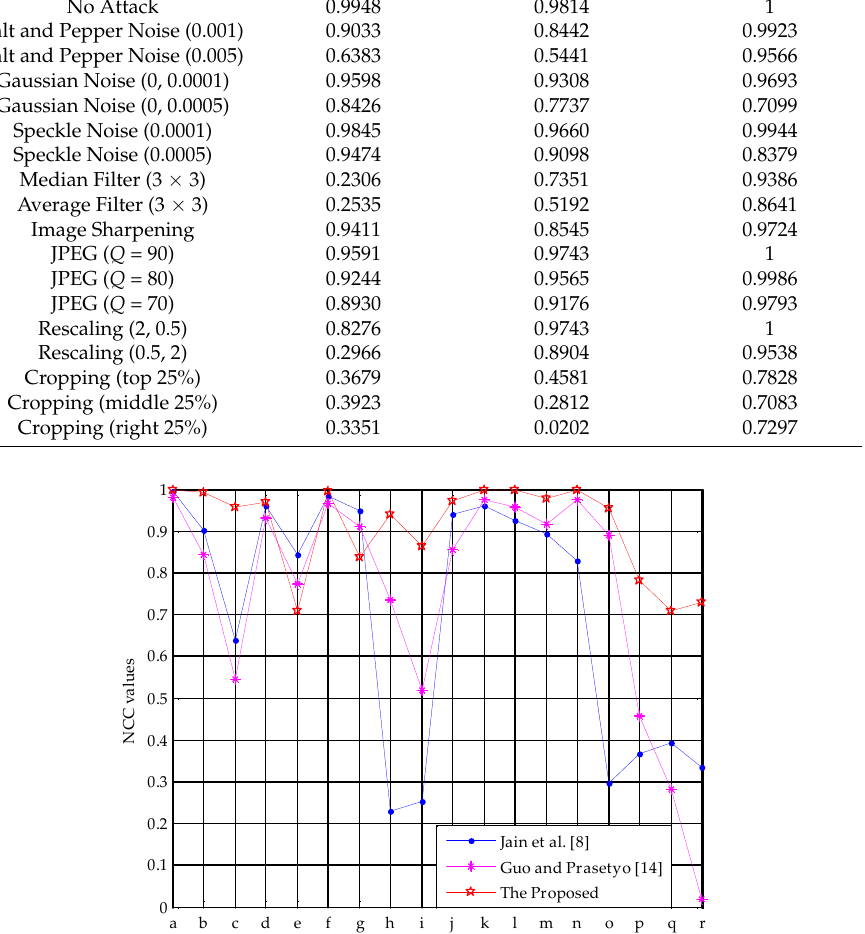
Figure 7. Robustness comparisons for host image Lena: ( a ) No attack; ( b ) Salt and pepper noise (0.001); ( c ) Salt and pepper noise (0.005); ( d ) Gaussian noise (0, 0.0001); ( e ) Gaussian noise (0, 0.0005); ( f ) Speckle noise (0.0001); ( g ) Speckle noise (0.0005); ( h ) Median filter (3 × 3); ( i ) Average filter (3 × 3); ( j ) Image sharpening; ( k ) JPEG ( Q = 90); ( l ) JPEG ( Q = 80); ( m ) JPEG ( Q = 70); ( n ) Rescaling (2, 0.5); ( o ) Rescaling (0.5, 2); ( p ) Cropping (top 25%); ( q ) Cropping (middle 25%); ( r ) Cropping (right 25%).